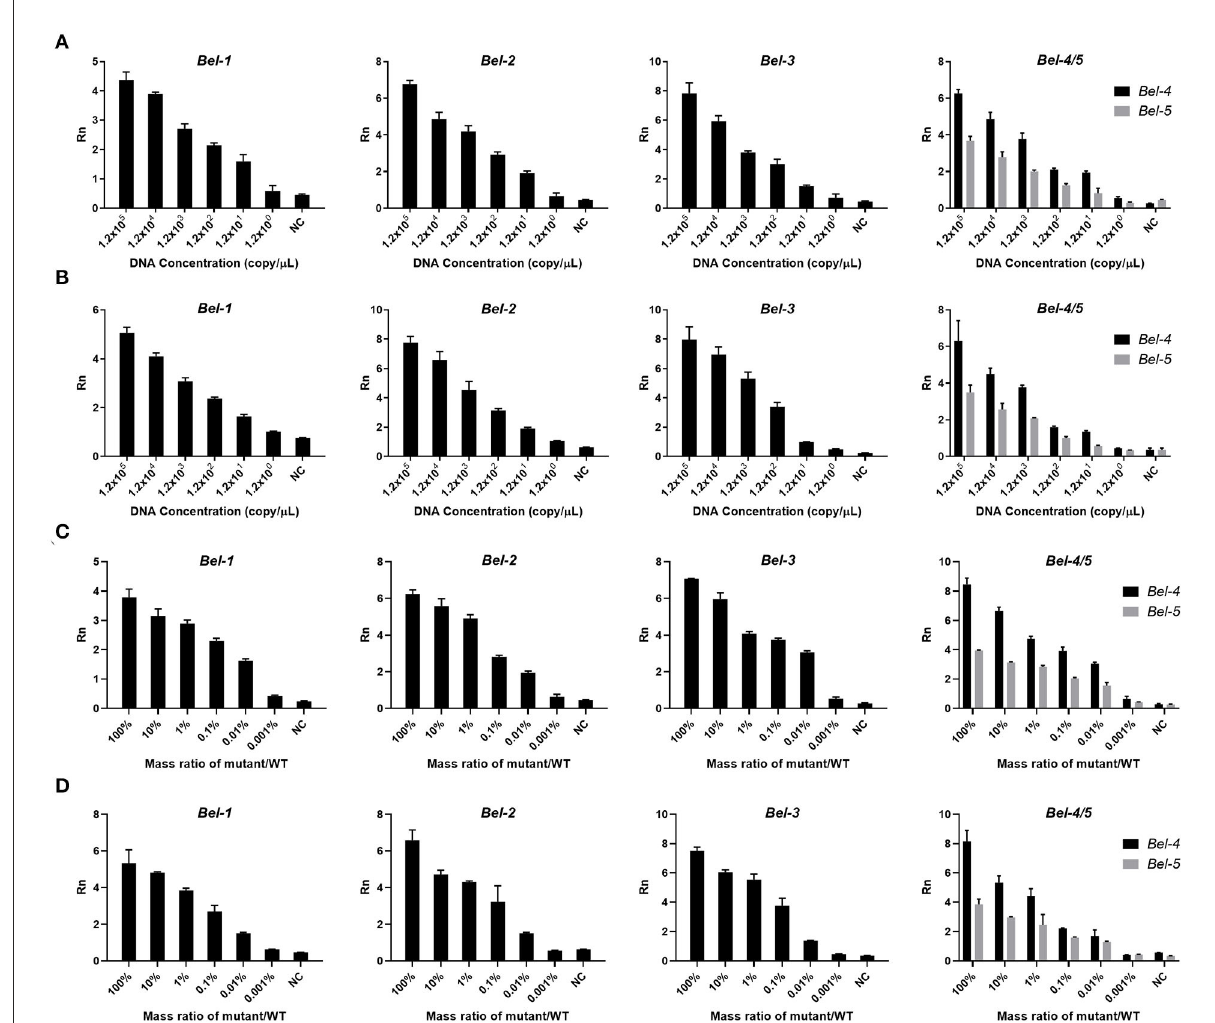
FIGURE5 Lower limit of detection (LOD) of Cas12aFVD. (A) LOD of mutants amplified by PCR. (B) LOD of mutants amplified by RPA. (C) LOD of the mixture of mutant and WT amplified by PCR. (D) LOD of the mixture of mutant and WT amplified by